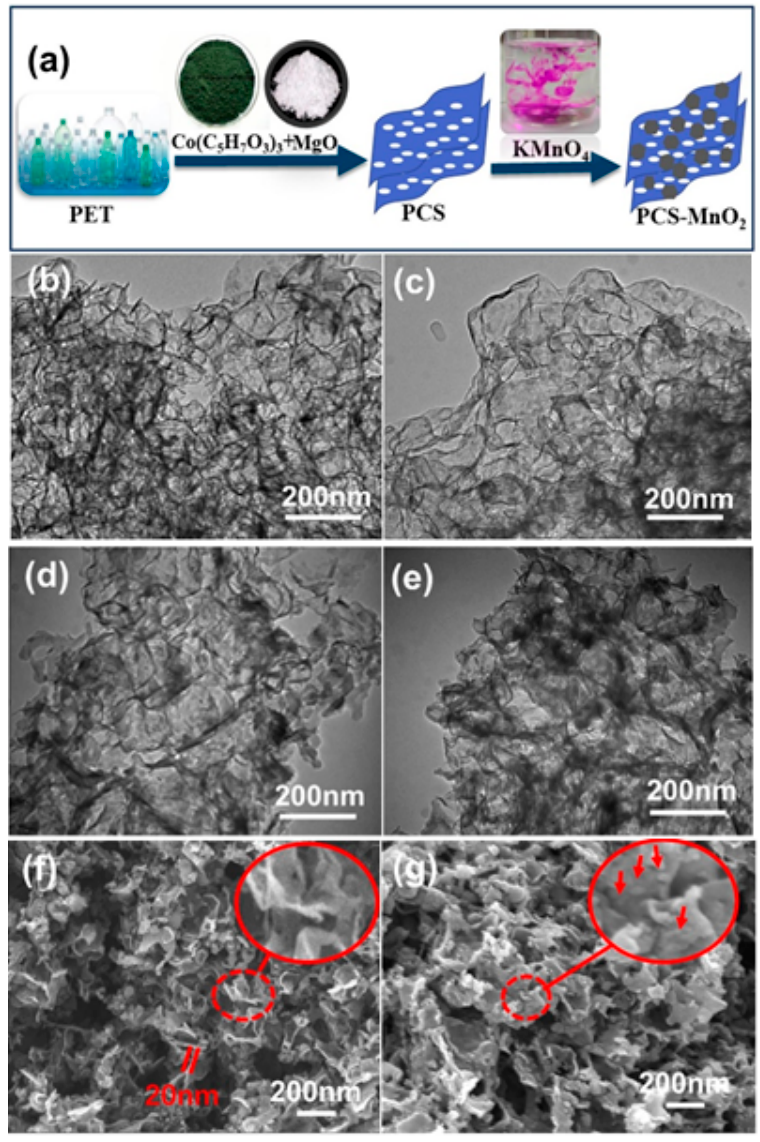
Figure 1. ( a ) Schematic illustration for the synthesis of PET waste derived PCS-MnO 2 . TEM images of